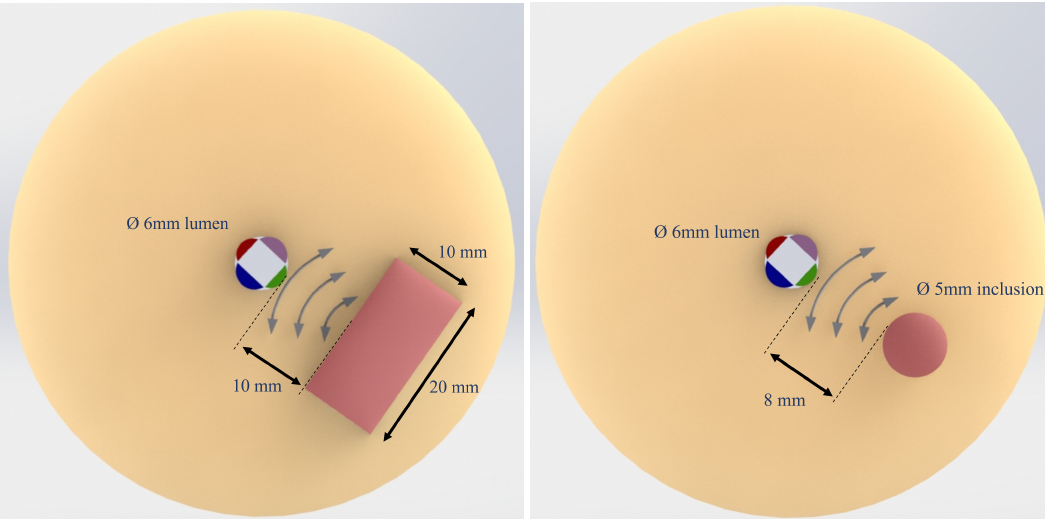
Figure 3. Schematic cross section of phantom A ( left ) and B ( right ) with the transluminal sensor inserted. Each receiver has been represented in a different color, where the green color indicates the element facing the stiffer inclusion, represented in red. Wave fronts of the reflected shear wave are shown as curved